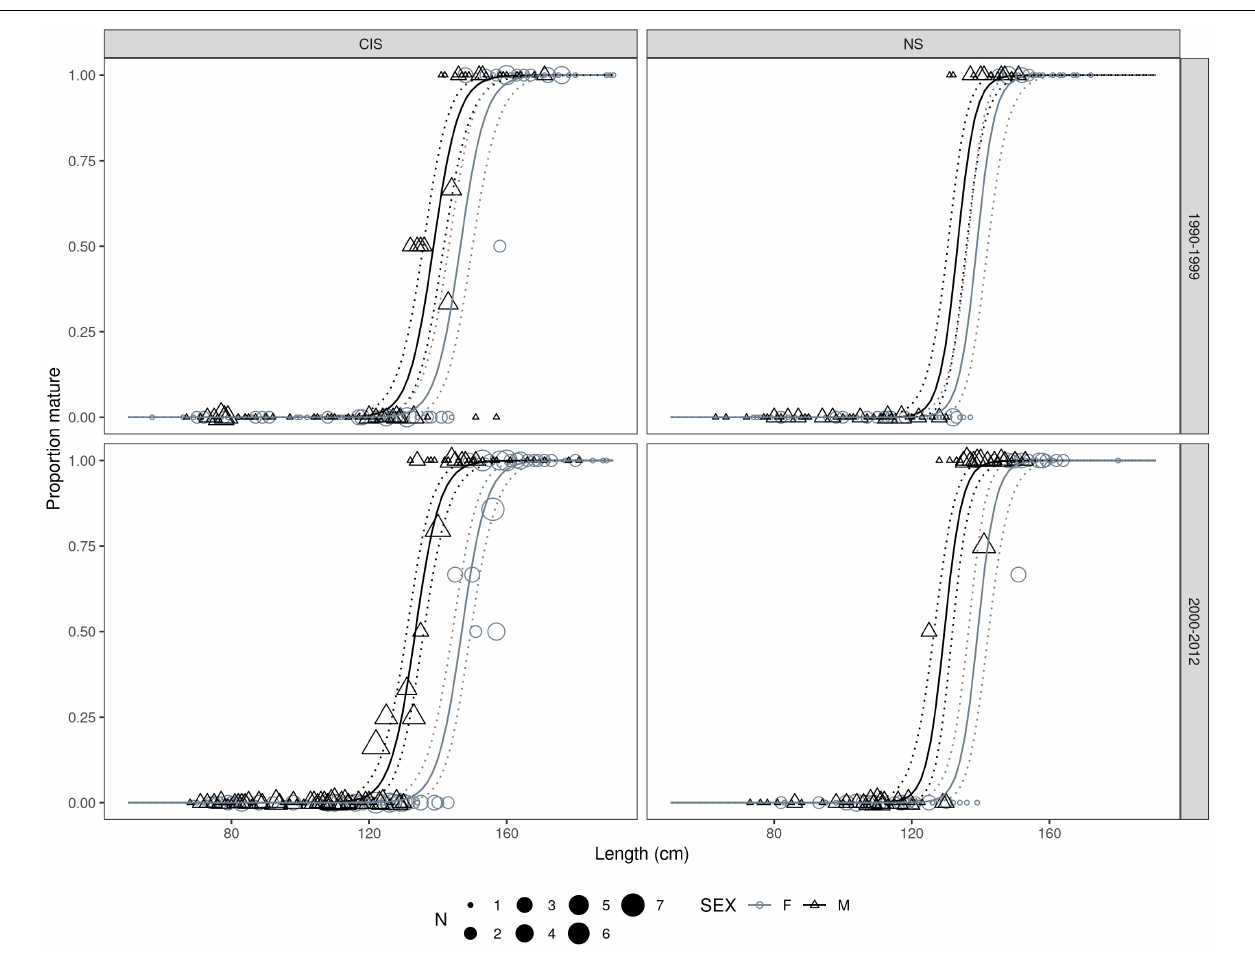
FIGURE 8 | Best fitting length (cm) at maturity model fits by management unit, time period, and sex. Points are scaled proportional to the number of observations for a given proportion. Solid and dashed curves represent the mean and 95% confidence intervals on the estimated proportion mature,